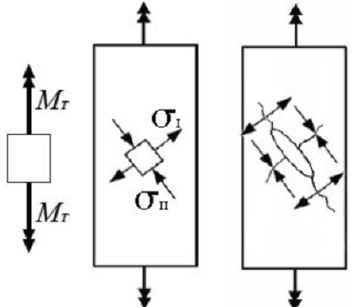
Figura 12: Direzione della coppia applicata Figura 13: Fotografia del provino danneggiato al